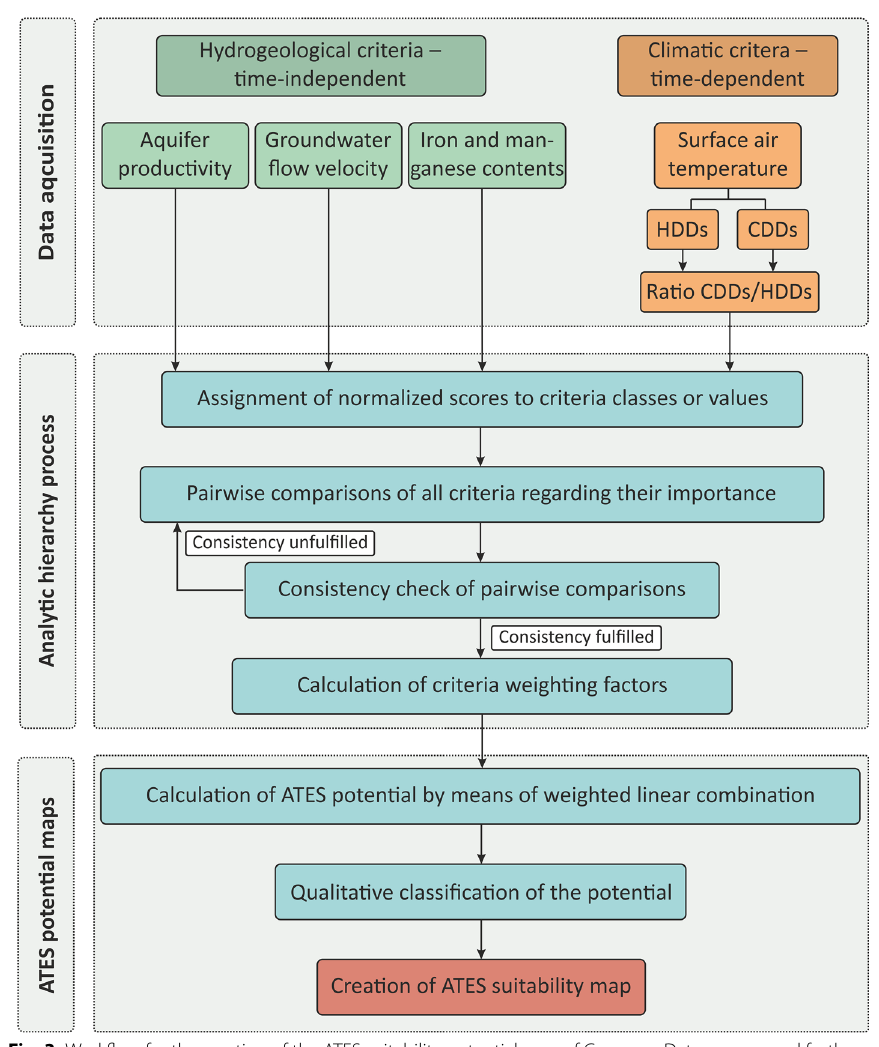
Fig. 3 Workflow for the creation of the ATES suitability potential map of Germany. Data sources and further details on the criteria are provided in Additional file 1: Table